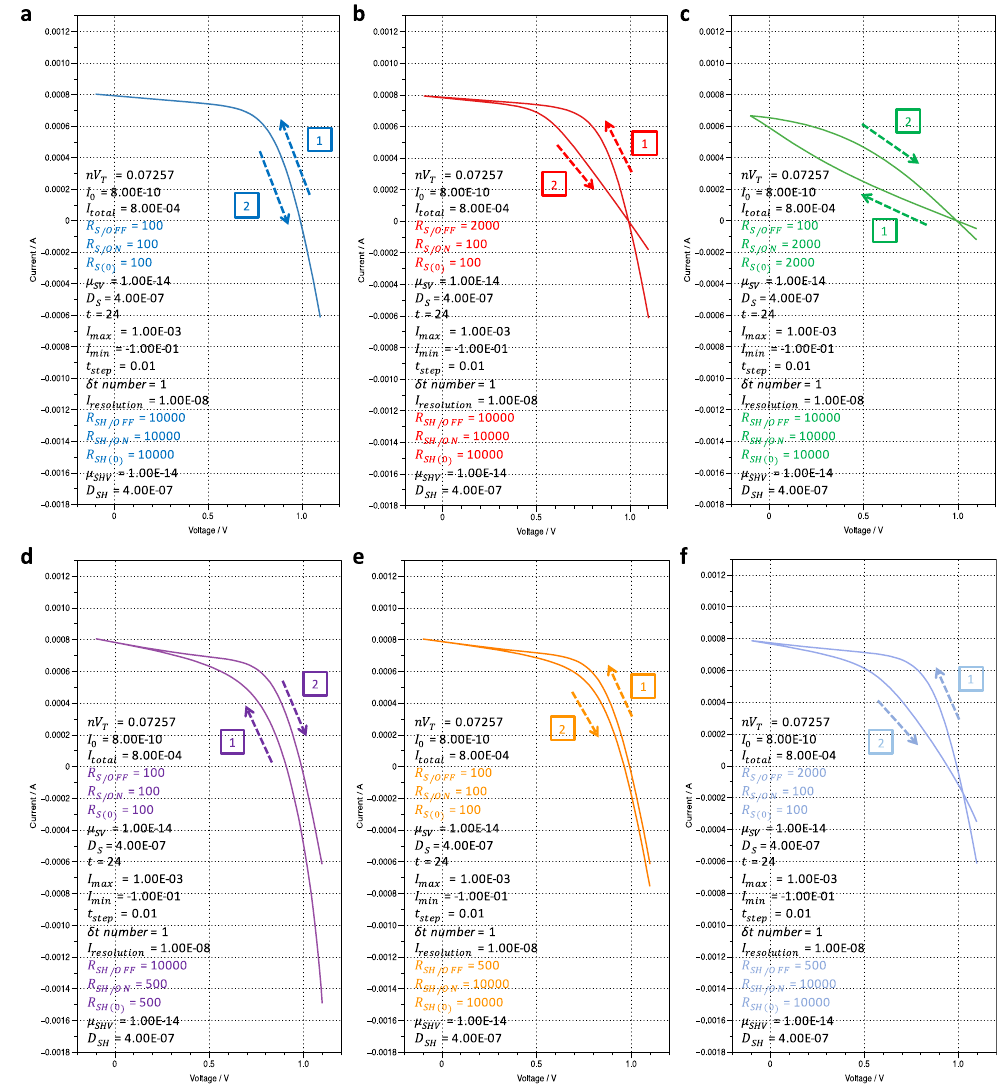
Figure 2. The simulated/computed results of the I–V characteristics of PSCs. ( a) Both R S ( t ) and R SH ( t ) show ohmic conduction property. ( b , c ) R SH ( t ) shows ohmic conduction property, whereas R S ( t ) shows memristive property with resistance that increases and decreases under positive applied voltage. ( d,e ) R S ( t ) shows ohmic conduction property, whereas R SH ( t ) shows memristive property with resistance that increases and decreases under positive applied voltage. ( f ) Both R S ( t ) and R SH ( t ) show memristive property. The marked numbers and arrows represent the voltage scan sequences and directions, respectively. The specific values of all the parameters used in the simulation/computation are listed in the corresponding charts using SI unit. Except for the colored ones, all others are the same for different cases